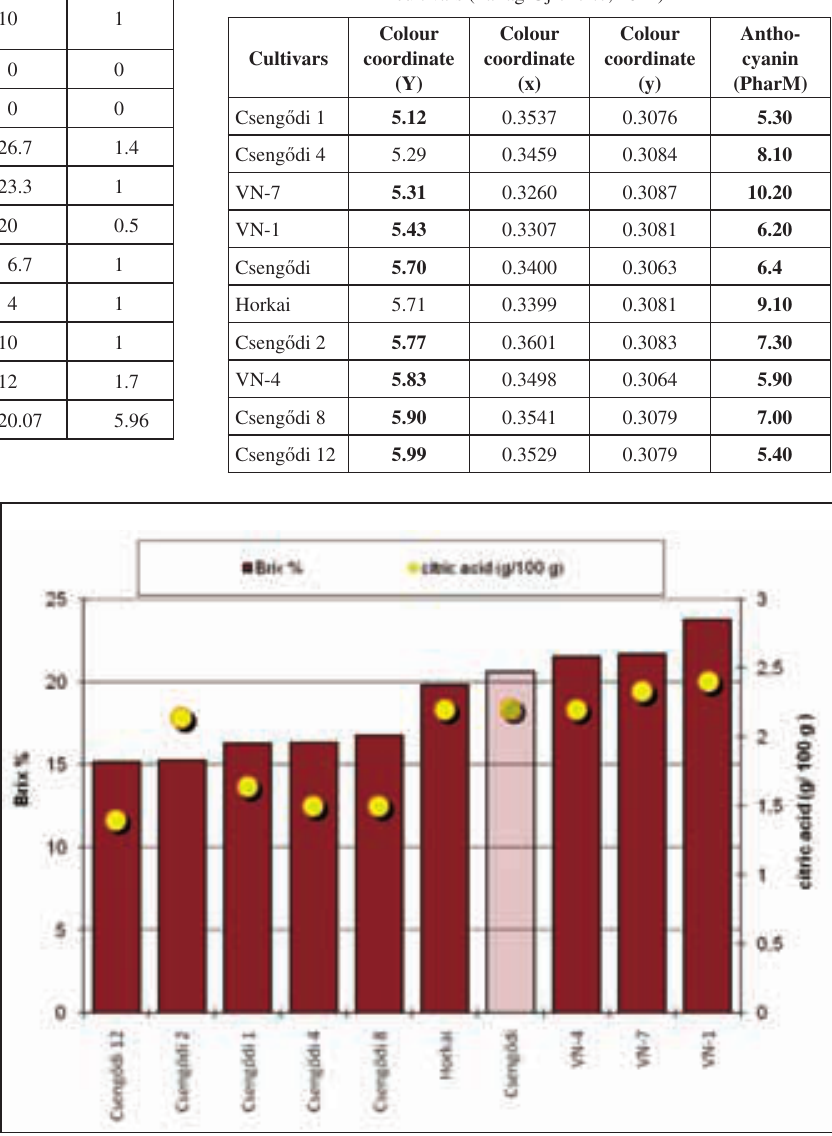
Figure 3. Brix % and citric acid of resistant sour cherry clones (Pallag-Újfehértó,